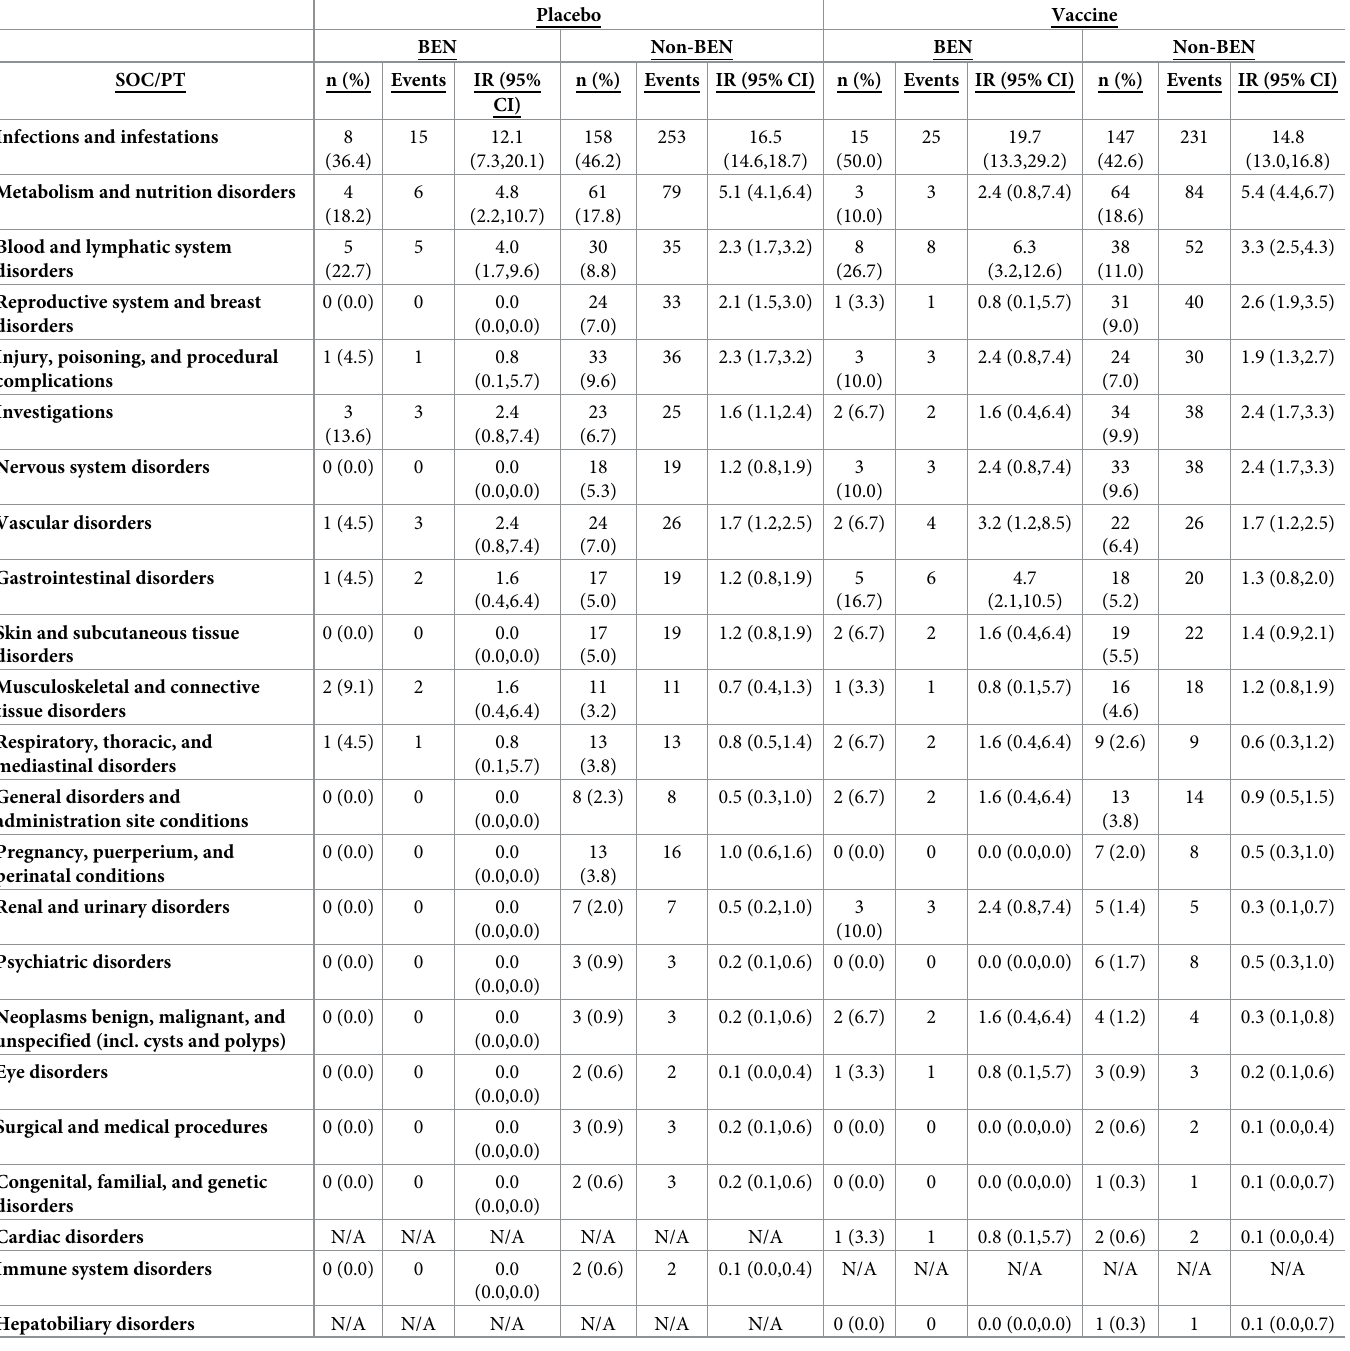
Table 4. Adverse events (Grade 1–5) by system organ class among Black participants in HVTN